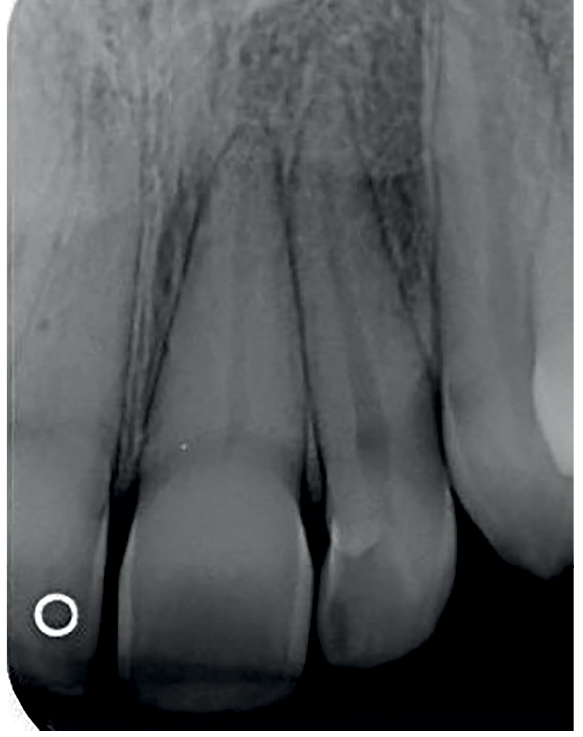
Figure 1. Partial PCO affecting tooth 21 after subluxation. Partial PCO usually affects the pulp chamber and the coronal part of the canal, whereas the radicular part remains visible, albeit markedly narrowed.